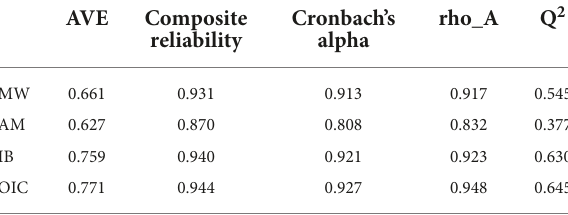
TABLE 2 SEM measurement model analysis